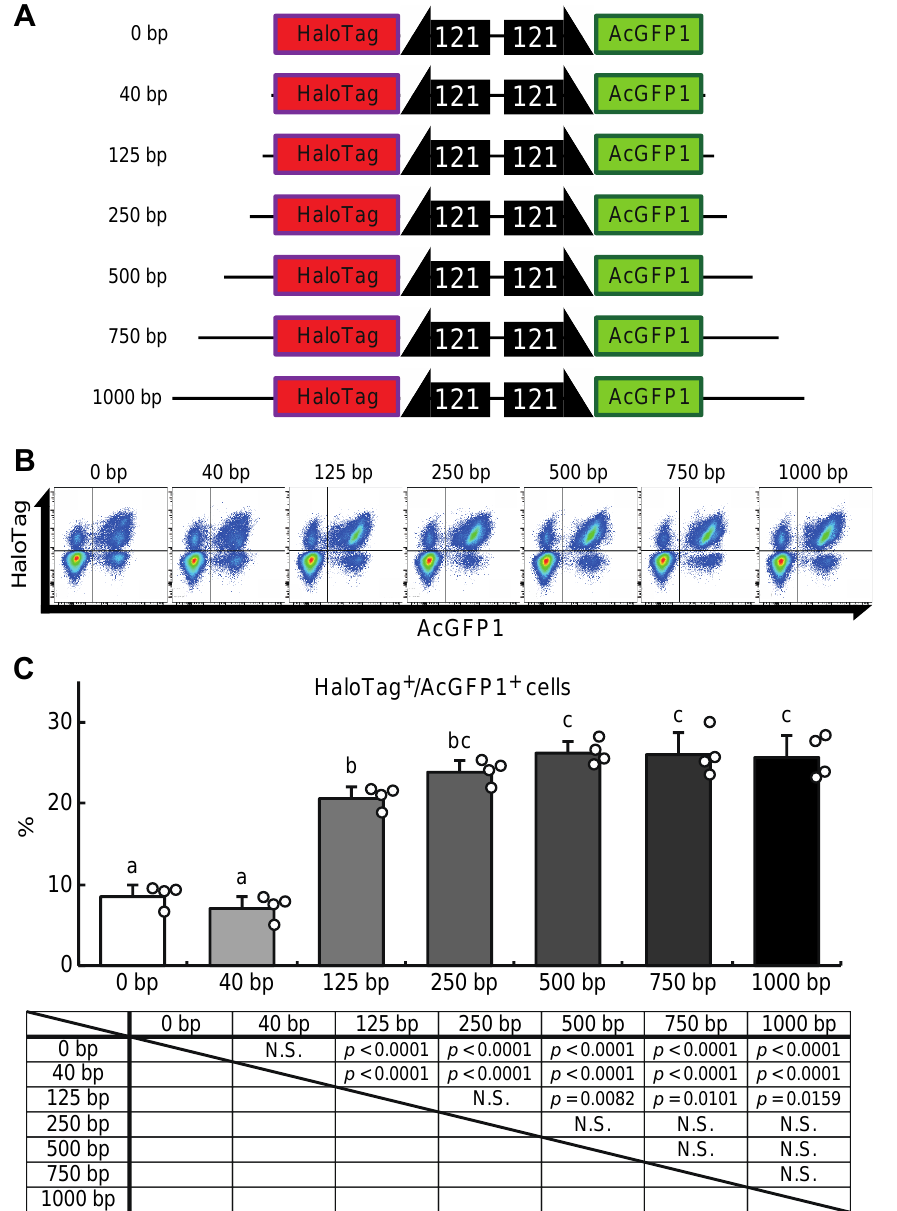
Figure 5. A donor vector construct for GOI expression and optimization of the homology arm length for maximum knock-in efficiency at the Chr1:21164645 site. ( A ) Schematic outline of donor vectors with different homology arm lengths in the range 0–1000 bp. ( B ) Representative dot plot data of transfected cells after zeocin selection showing AcGFP1 and HaloTag fluorescence. ( C ) The proportions of AcGFP1 + and HaloTag + cells in the live-cell population analyzed using a flow cytometer after 10 days in culture with zeocin selection, and the result of the statistical analysis. Values are expressed as mean ± SD; n = 4 in each group. N.S., not significant. Different letters above each bar indicate significant differences among groups at p = 0.05 as shown in the statistical analysis. The darker shade indicates the longer homology arm